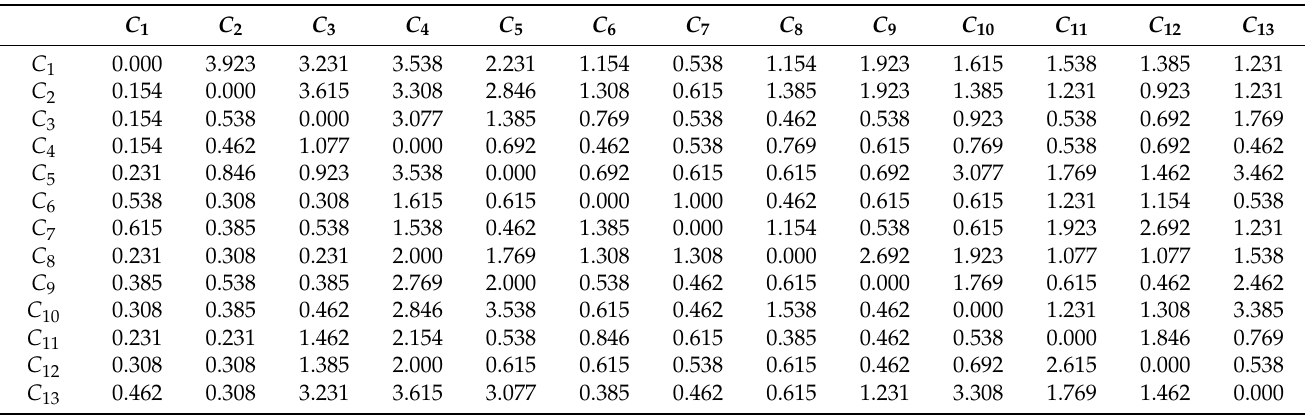
Table 3. Initial influence matrix A